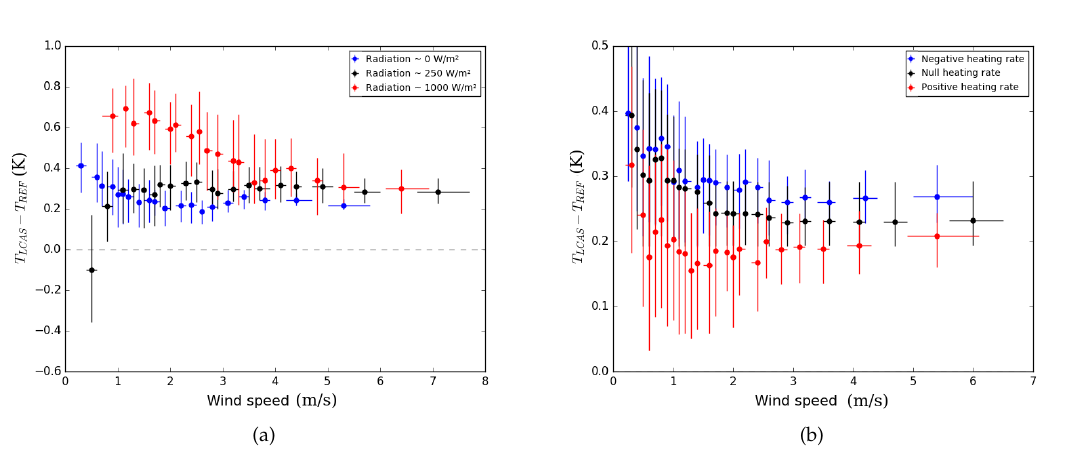
Figure 7. Evolution of the error within LCAS shelter against the wind speed ( a ) for low heating rate ( ˙ T ∼ 0.6 K · h − 1 ) and several radiation values and ( b ) for low radiation ( K ↑ + K ↓ heating rate values. Please note that each dot/error bars represents the median/quartiles values of a 5-percentile interval of wind speed.